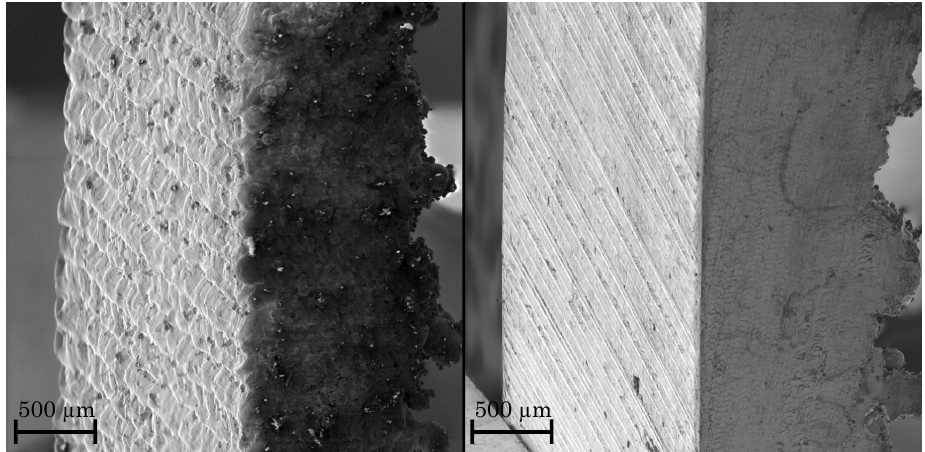
Figure 9. Comparison of highly inclined (inclination angle = 10 ◦ ) SLM-built ( left ) and hybrid manufactured ( right ) parts.